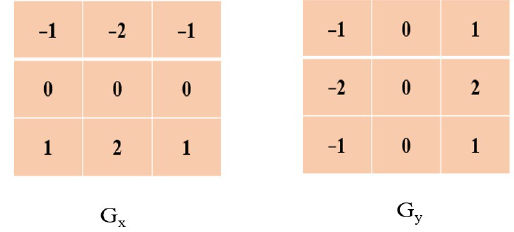
Figure 3. Sobel Mask.